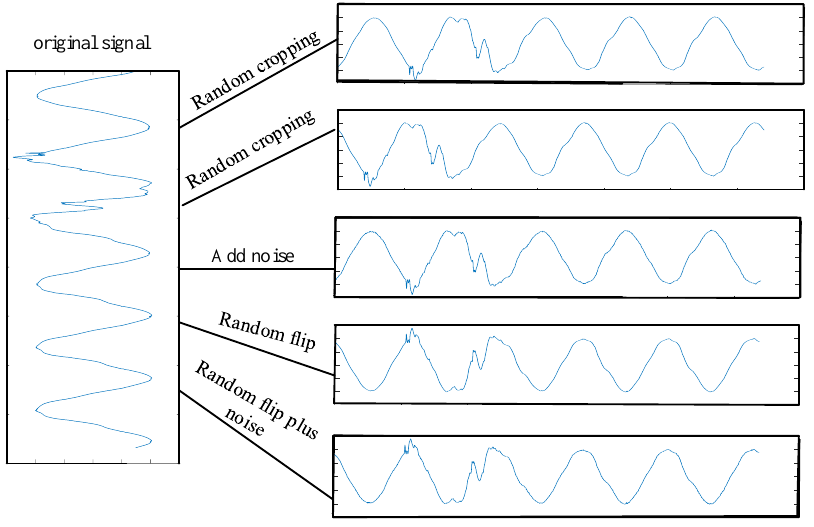
Figure 8. Data enhancement operation diagram.